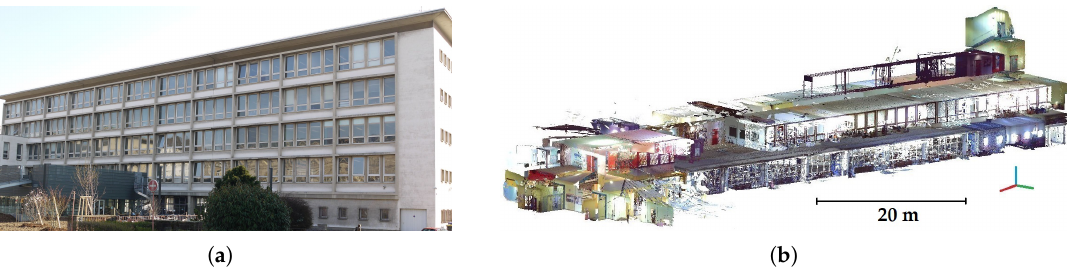
Figure 2. Dataset used to illustrate the approach: ( a ) Photograph of the acquired building. ( b ) Indoor colourized point clouds ( ∼ 1.7 billion points before